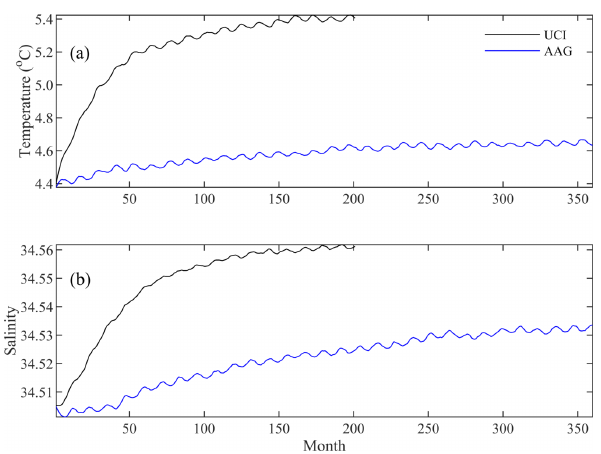
Figure 7. The time series of the domain-averaged monthly mean (a) temperature and (b) salinity in the 1000m layer simulated using the scheme combinations of UCI (black line) and AAG (blue